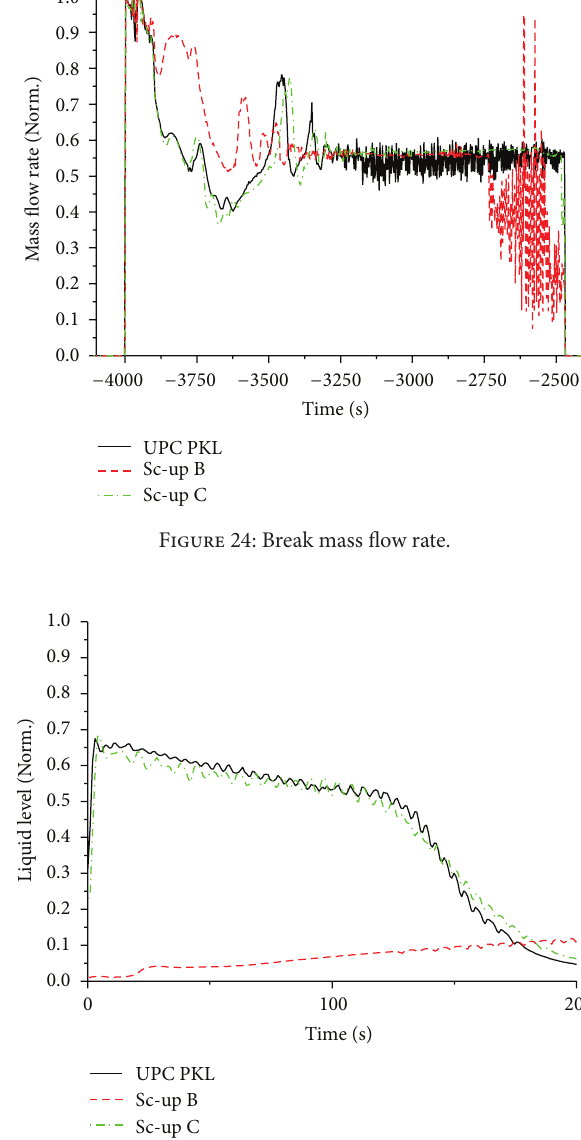
Figure 23: HL liquid level.